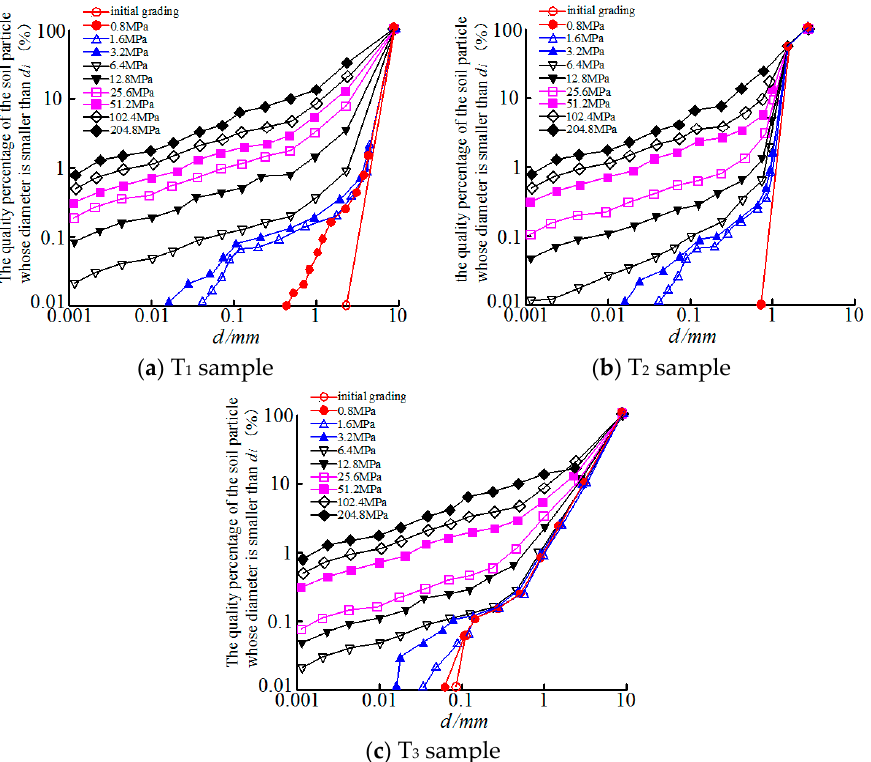
Figure 5. Evolution of particle size distributions (double logarithmic axes): ( a ) T1 sample, ( b ) T2 sample and ( c ) T3 sample.